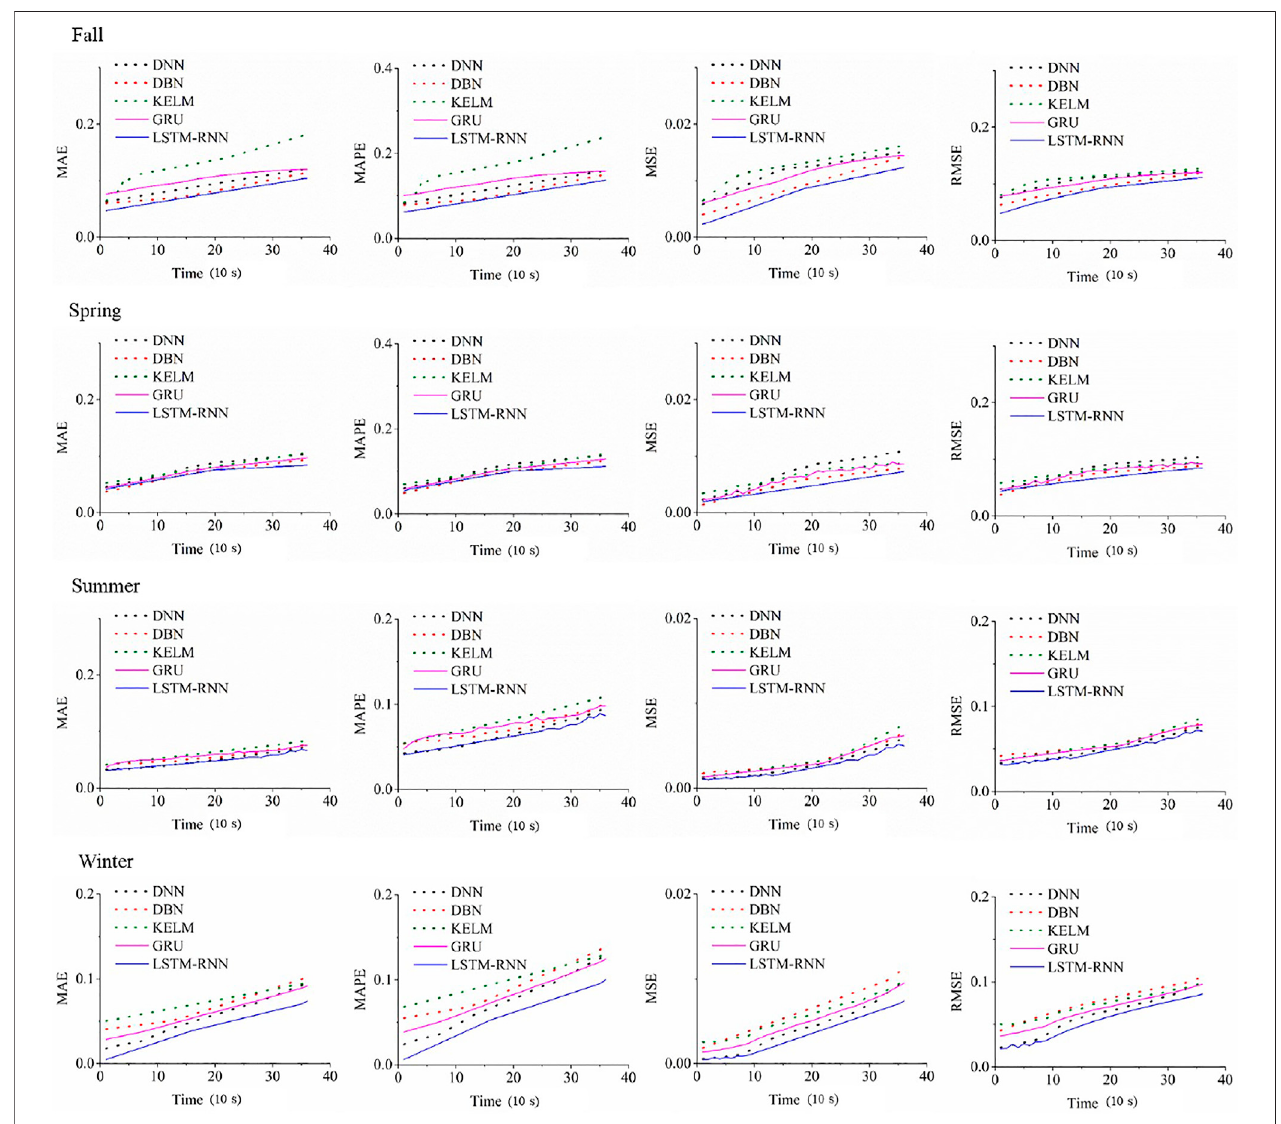
FIGURE 6 | Performance of all measurement metrices with various prediction horizons in four seasons.